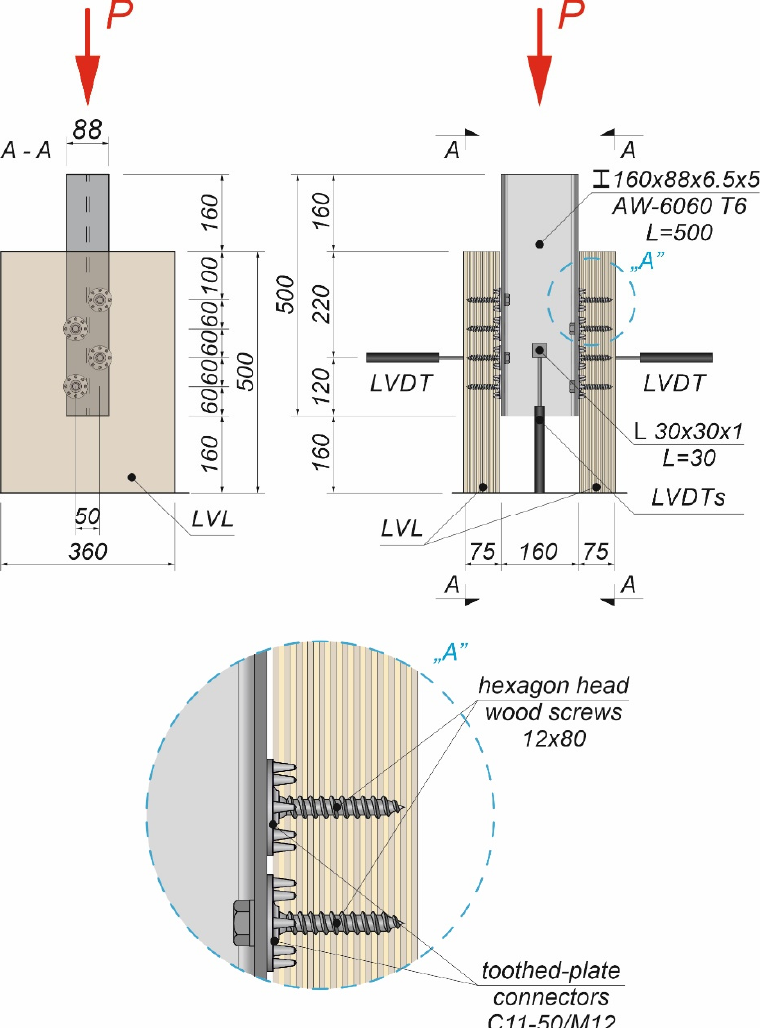
Figure 6. The location of the LVDTs on the specimen with reinforcing toothed plates—screws 12 × 80 and toothed-plate connectors (type C11-50/M12, Geka).